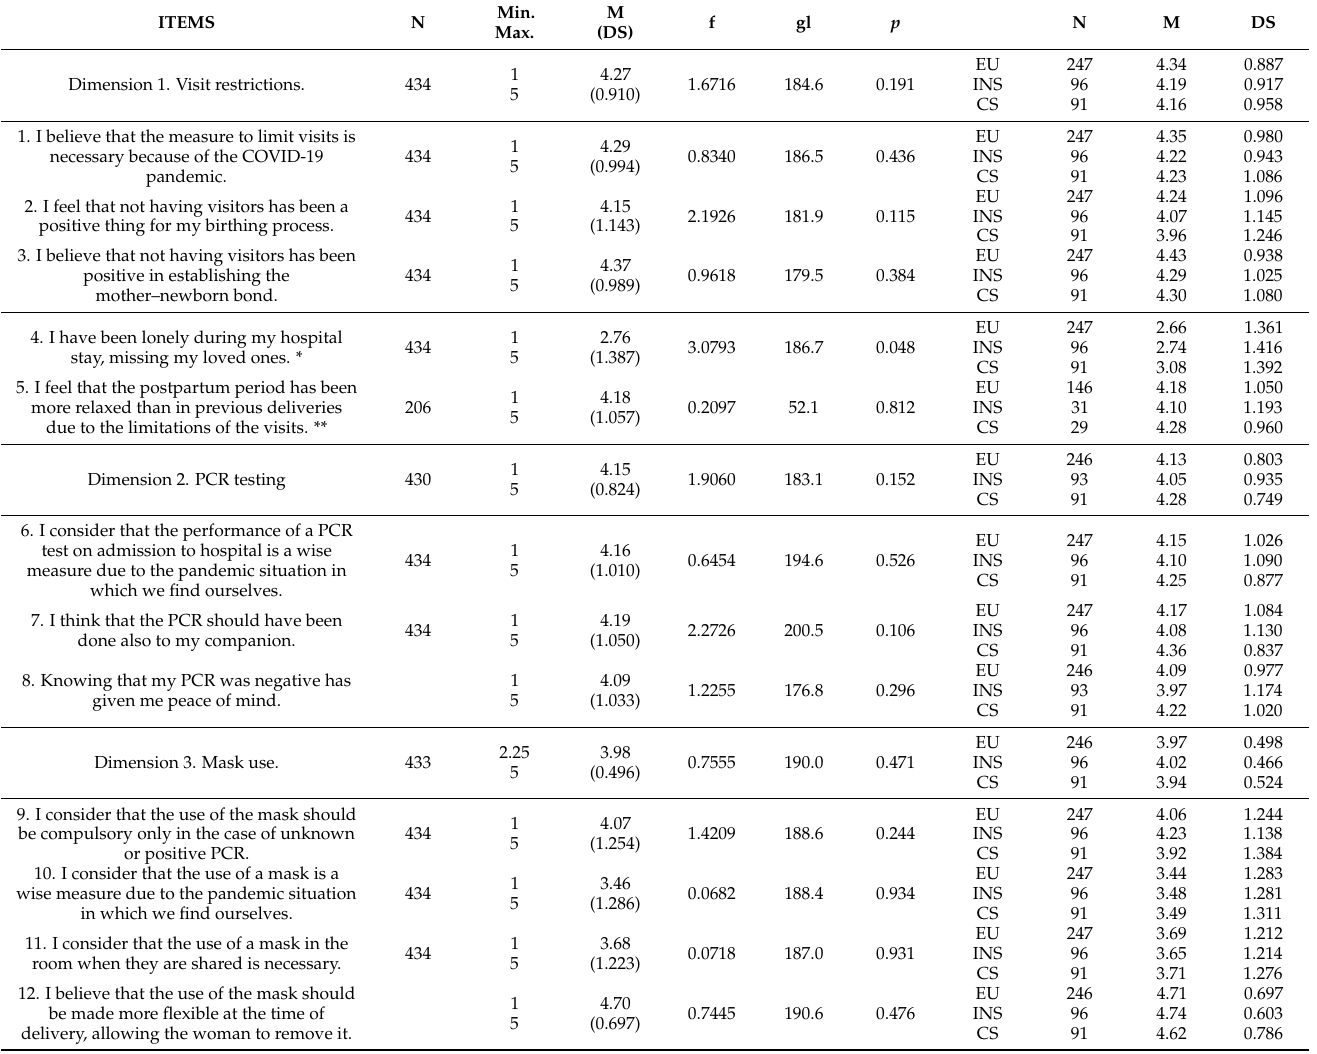
Table 4. Inferential statistics. ANOVA for type of